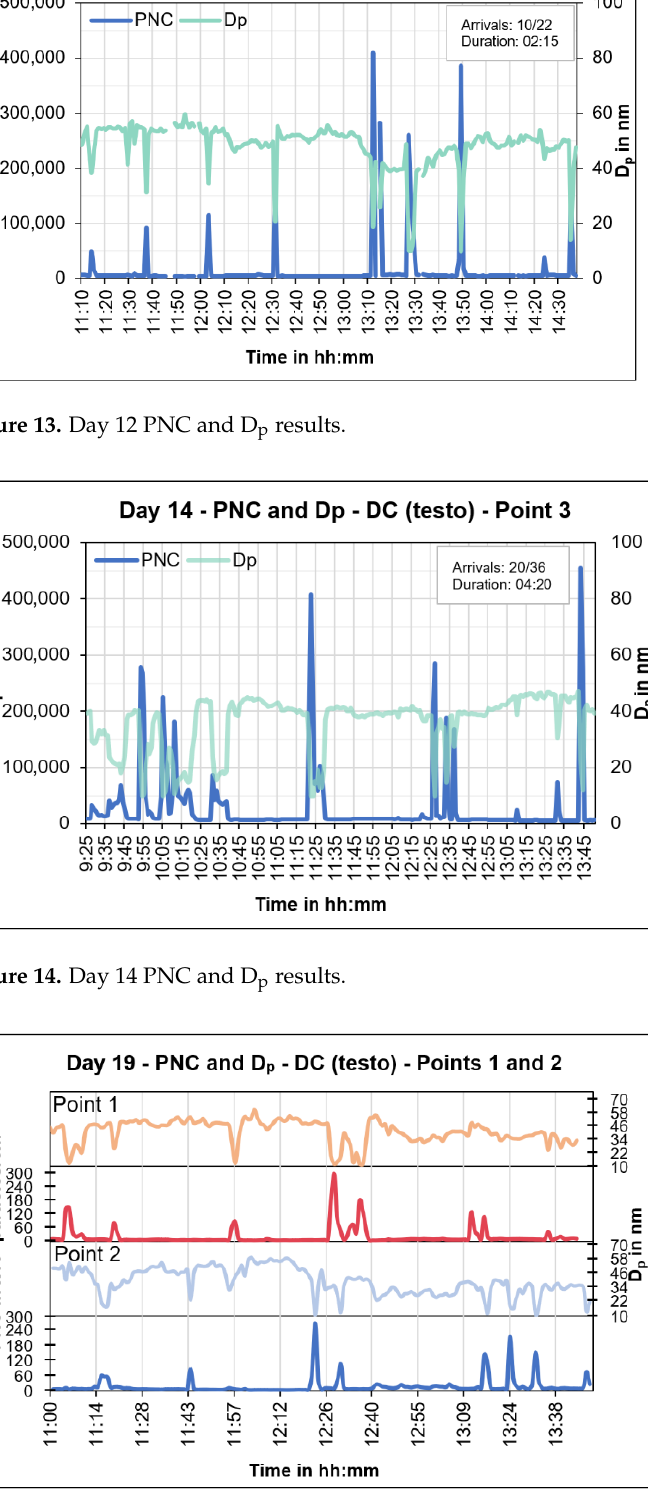
Figure 15. Parallel measurements at points 1 and 2.